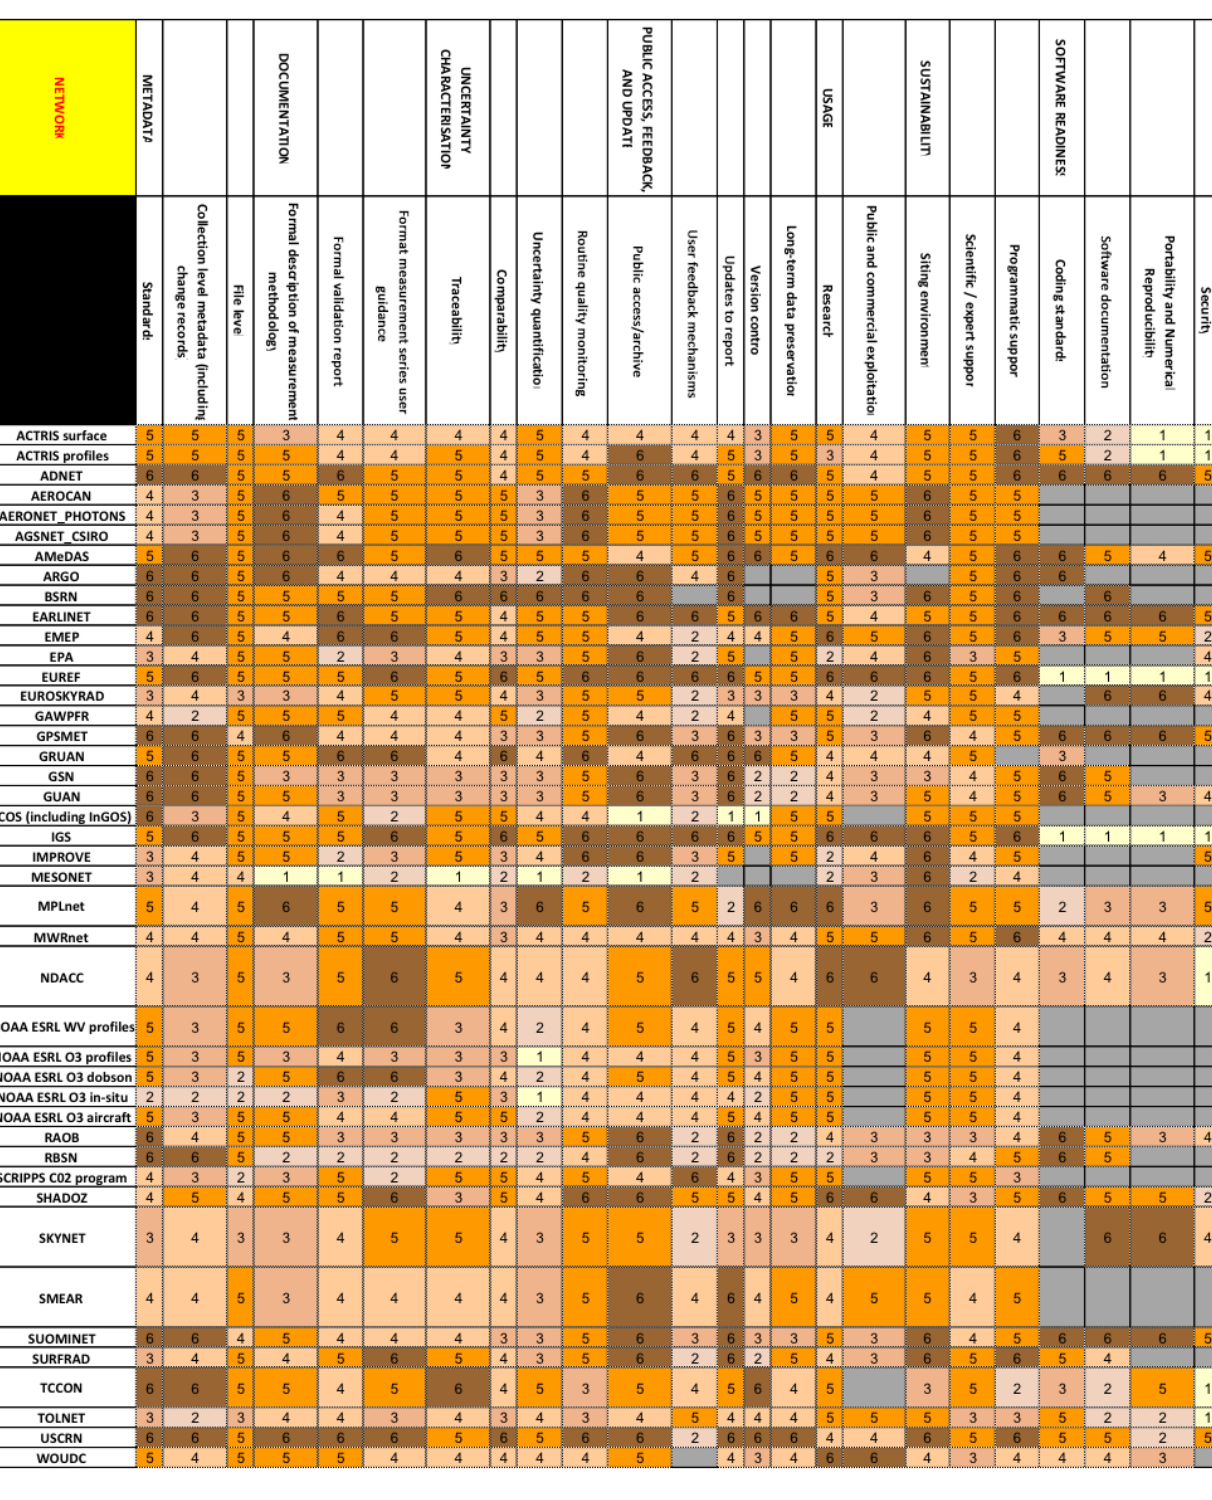
Figure 4. Summary of assessment results for all the networks that were assessed by GAIA–CLIM as detailed in Appendix A. Note that colour assignments follow the inline key given in Fig.